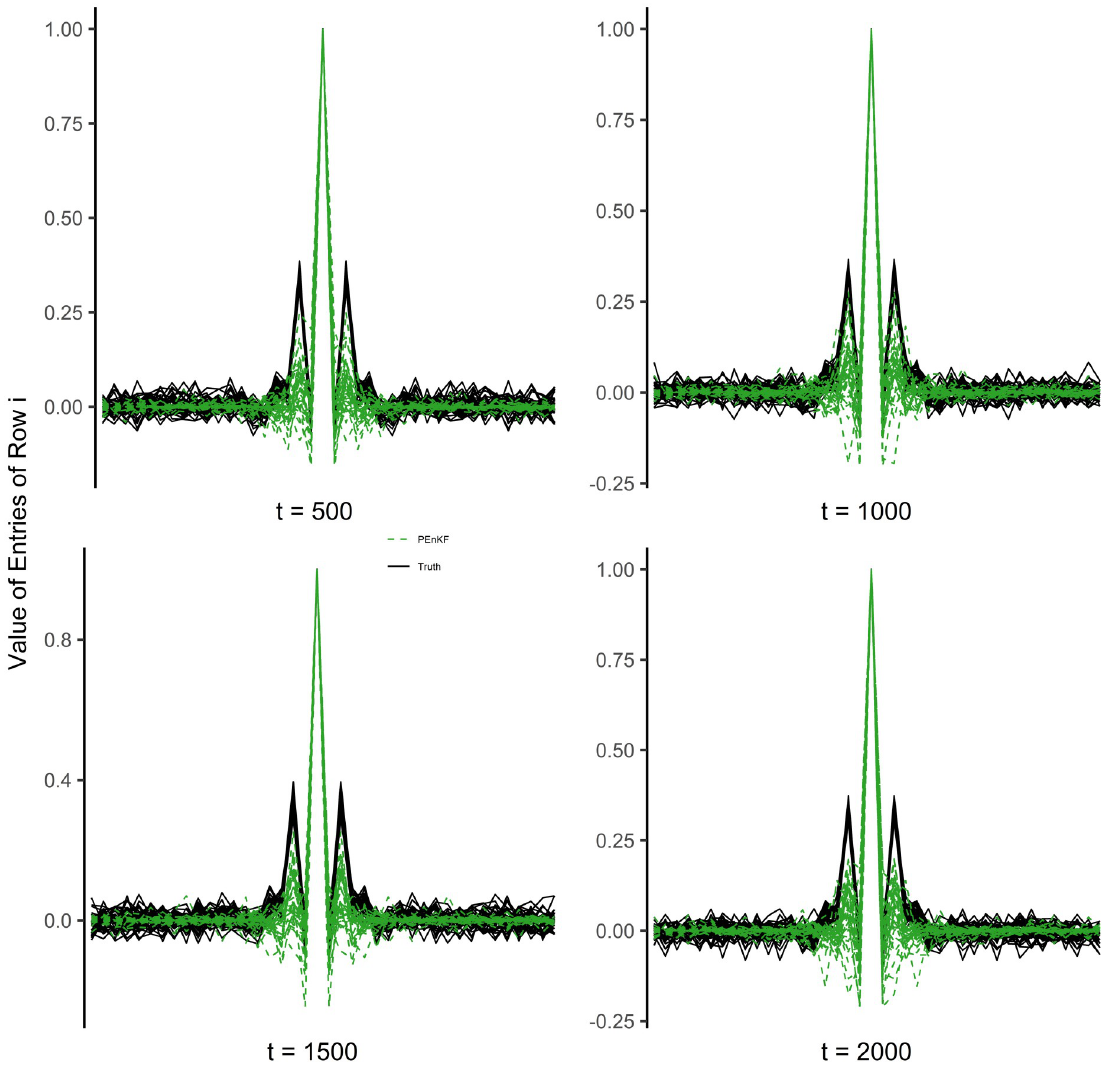
Fig 1. Each line represents the normalized values of a row of the inverse covariance matrix averaged over 50 trials. The x-axis shows the entries of a row i ordered from i − 20 to i + 20, so that the middle of the x-axis is the “diagonal” of the row and the values further from the center of the x-axis are further from the “diagonal”. The PEnKF algorithm is successful at identifying that the state variables far away from variable i have no effect on it, even though there are fewer ensemble members than state